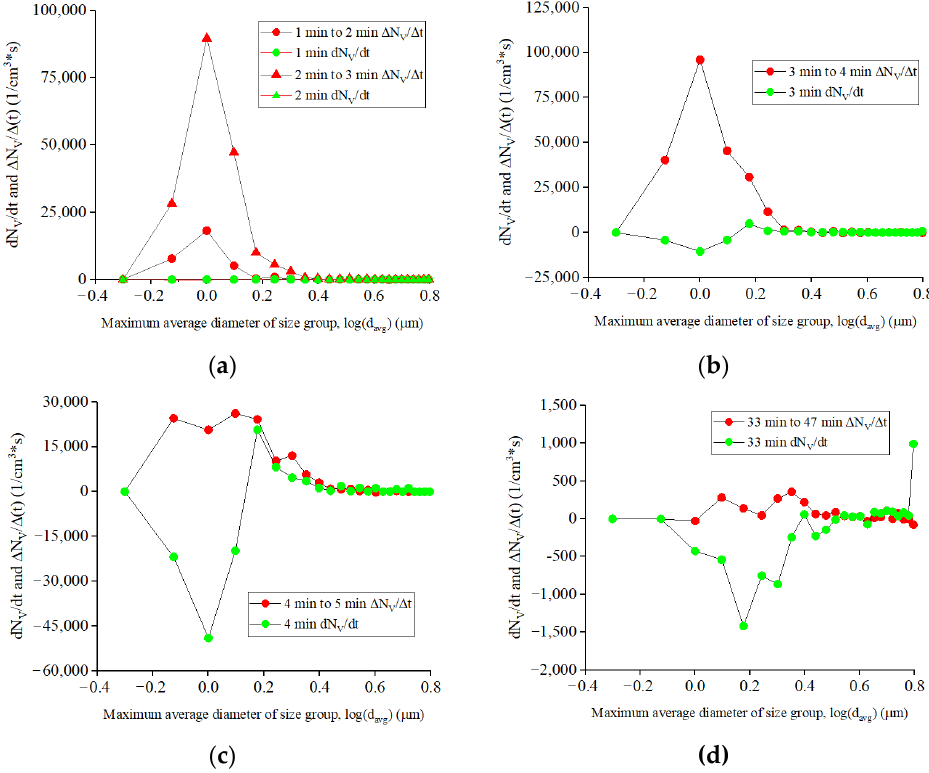
Figure 14. Comparison of the observed rate of change of CaS population density and the calculated rate of change of population density due to collision in the ladle at ( a ) 1 min and 2 min, ( b ) 3 min, and ( c ) 4 min after Ca addition, and ( d ) in tundish at 33 min after Ca addition.